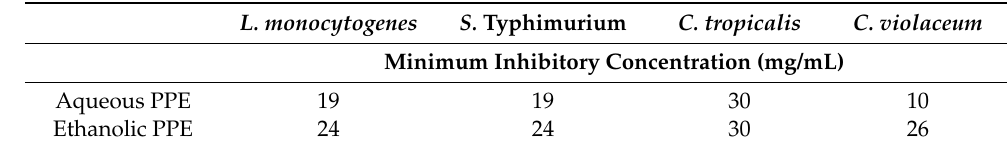
Table 2. In vitro antimicrobial activity of pomegranate peel extracts (PPE). L.